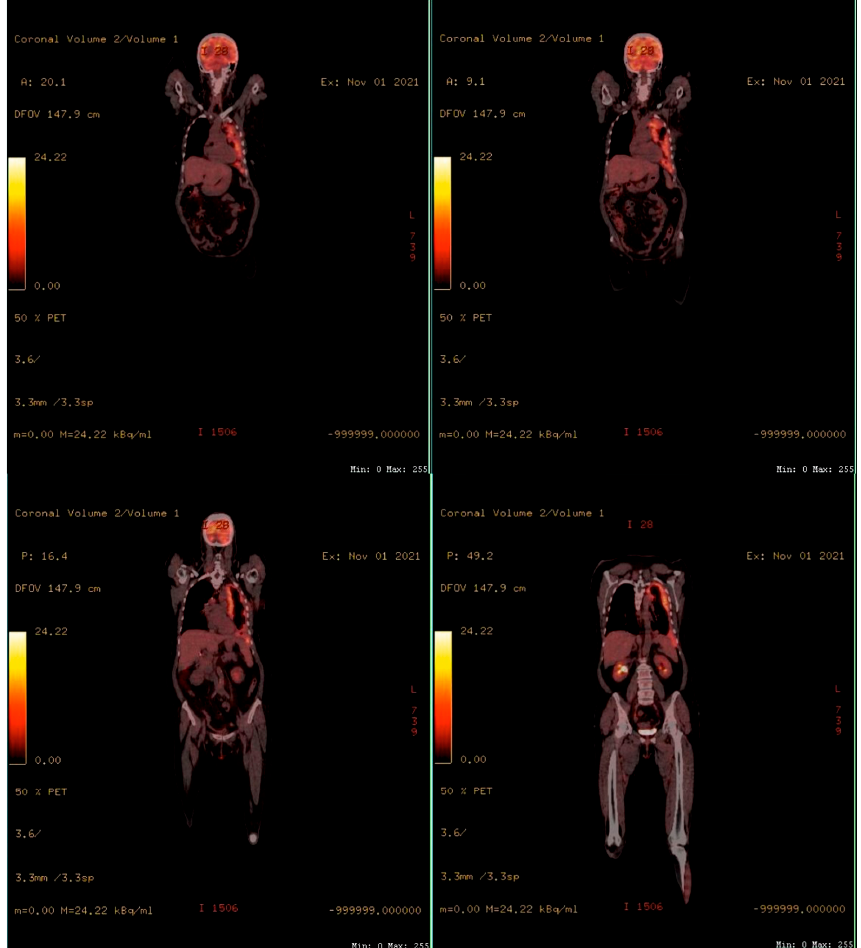
Table 1. Immunohistochemical tests results.